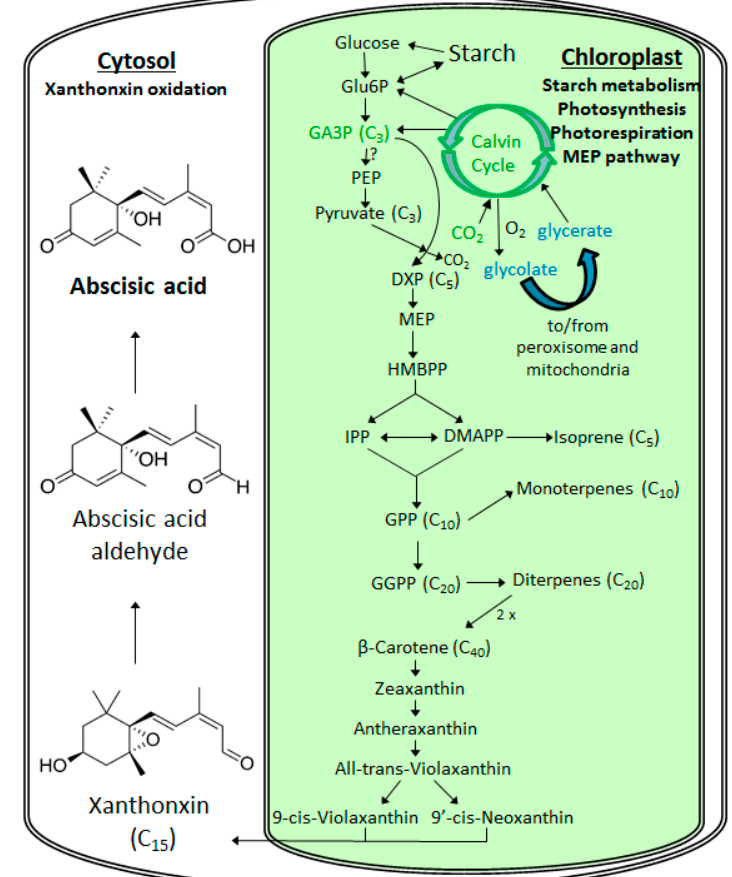
Figure 1. Simplified diagram of the 2-C-methyl- D -erythritol-4-phosphate (MEP) pathway for phytohormone abscisic acid (ABA) biosynthesis with components occurring in the Chloroplast and Cytosol. ABA is derived from C 40 epoxycarotenoid precursors through an oxidative cleavage reaction in chloroplasts. The C 15 intermediate xanthoxin is converted to ABA by a two-step reaction via ABA-aldehyde in the cytosol. The green intermediates (CO 2 and glyceraldehyde-3-phosphate, G3P) represent the substrate and product of photosynthesis in the Calvin Cycle) with blue photorespiratory intermediates (glycolate and glycerate).